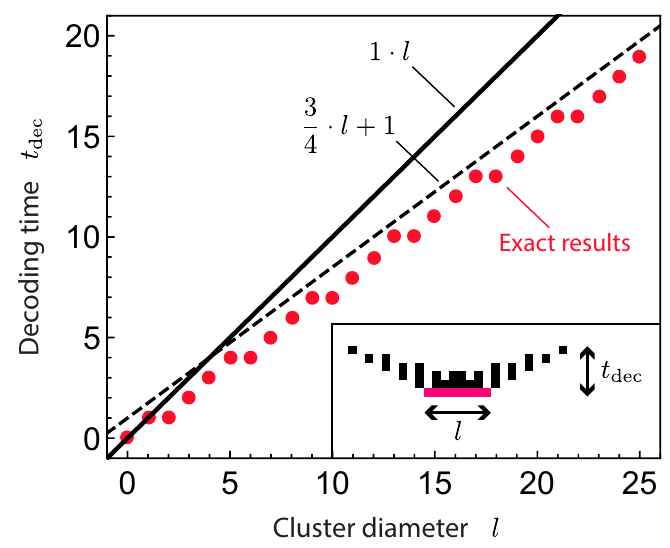
Figure 14: Eroder parameter. Time t needed by TLV to erase a homogeneous cluster of dec diameter l completely. The red bullets mark exact results from simulations, featuring a 4- periodic structure that derives from the rules of radius R = 4. The most stringent upper bound ≤ 3 · l + 1 (dashed line) but we use t ≤ 1 · l (solid line) for the sake of is given by t dec dec 4 simplicity (i.e., m = 1). These bounds are also valid for non-homogeneous clusters due to the monotonicity of